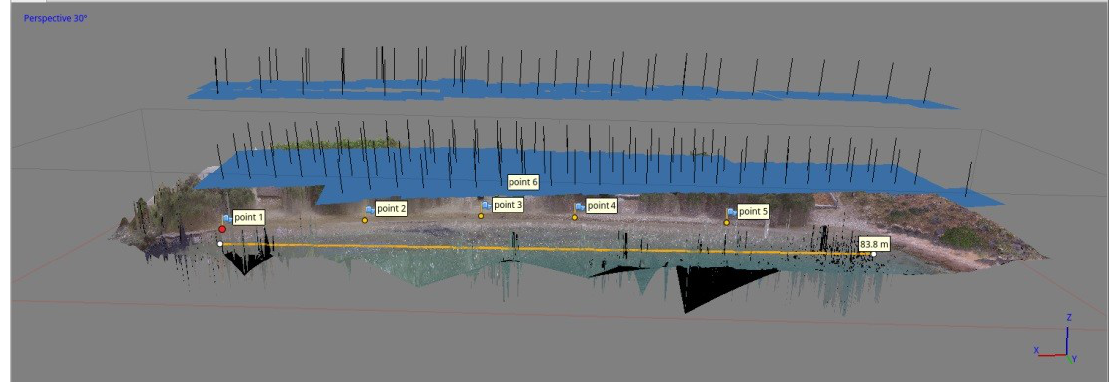
Figure 2. UAV image acquisition at 20 and 30 m altitude. The allocation of the ground control points (GCPs) is also presented. The intermediate flight at 25 m is intentionally not presented in the current figure.